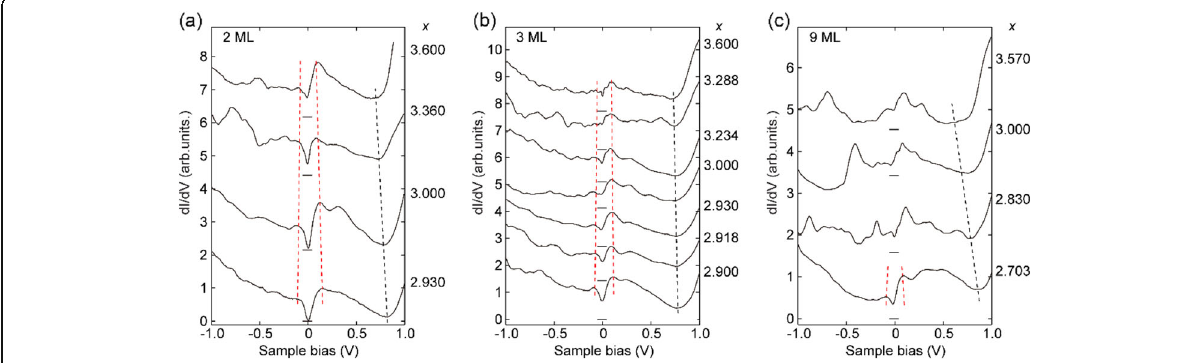
Fig. 15 Spatially averaged d I /d V spectra as a function of electron doping x , measured on ( a ) 2 ML; ( b ) 3 ML; ( c ) 9 ML K x C 60 . The red dashed lines mark the doping evolution of UHB and LHB, with the black dashed ones signifying K-doping. Taken from ref.